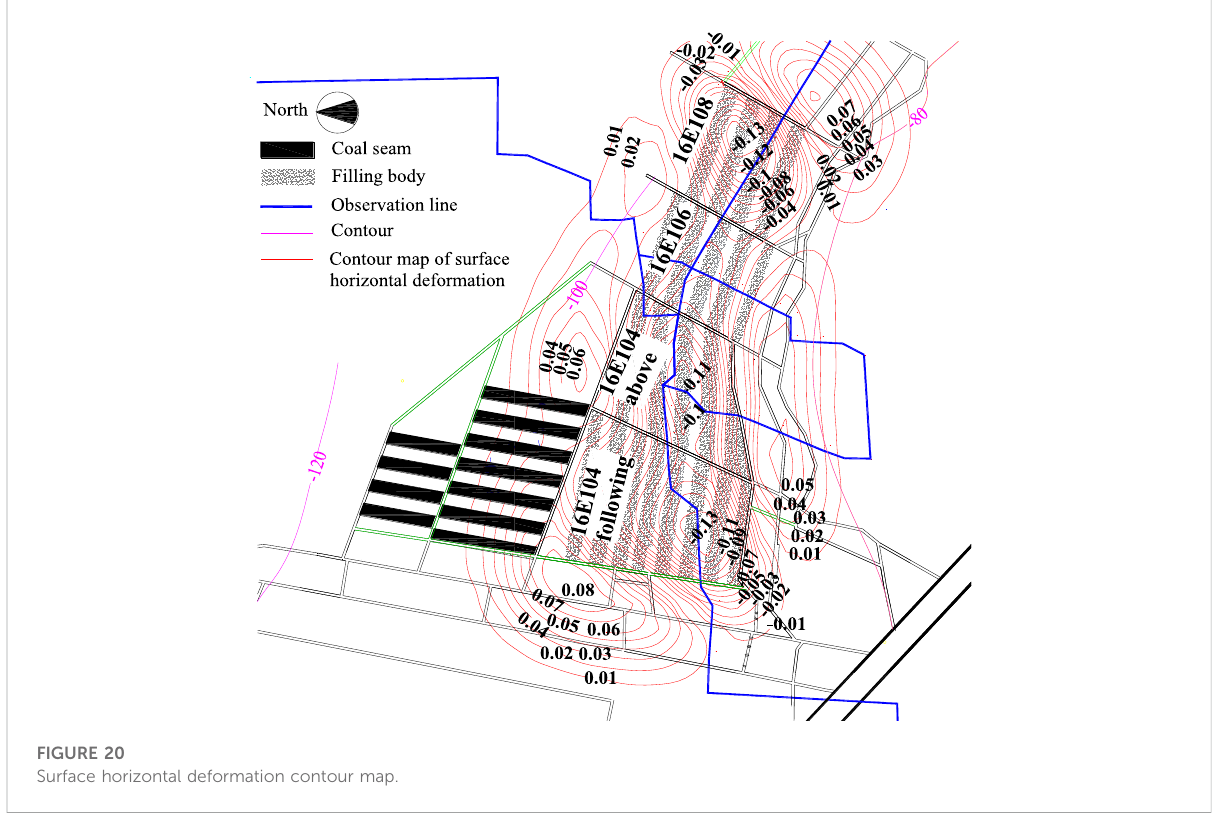
FIGURE 20 Surface horizontal deformation contour map.